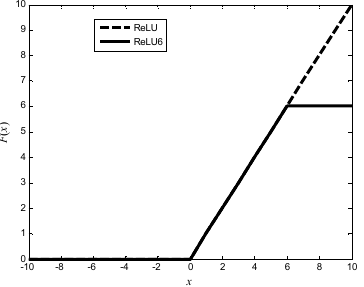
Figure 7. Graphs of ReLU6 and ReLU.